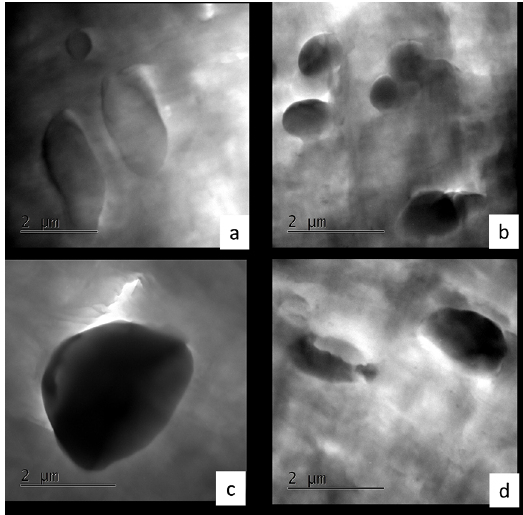
Figure 4. TEM micrographs of: (a) 90/10/0 (b) 89/10/1 (c) 87.5/2.5/0 (d) 86.5/2.5/1. Table 3. Average diameter of the dispersed phase HDPE/Epoxy/ PE-co-PEG HDPE/Epoxy/PE-co-PEG